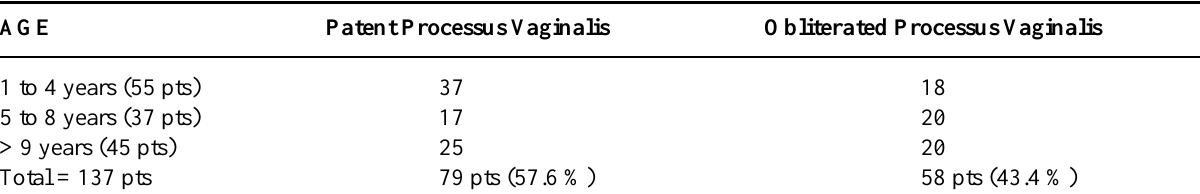
AGE Patent Processus